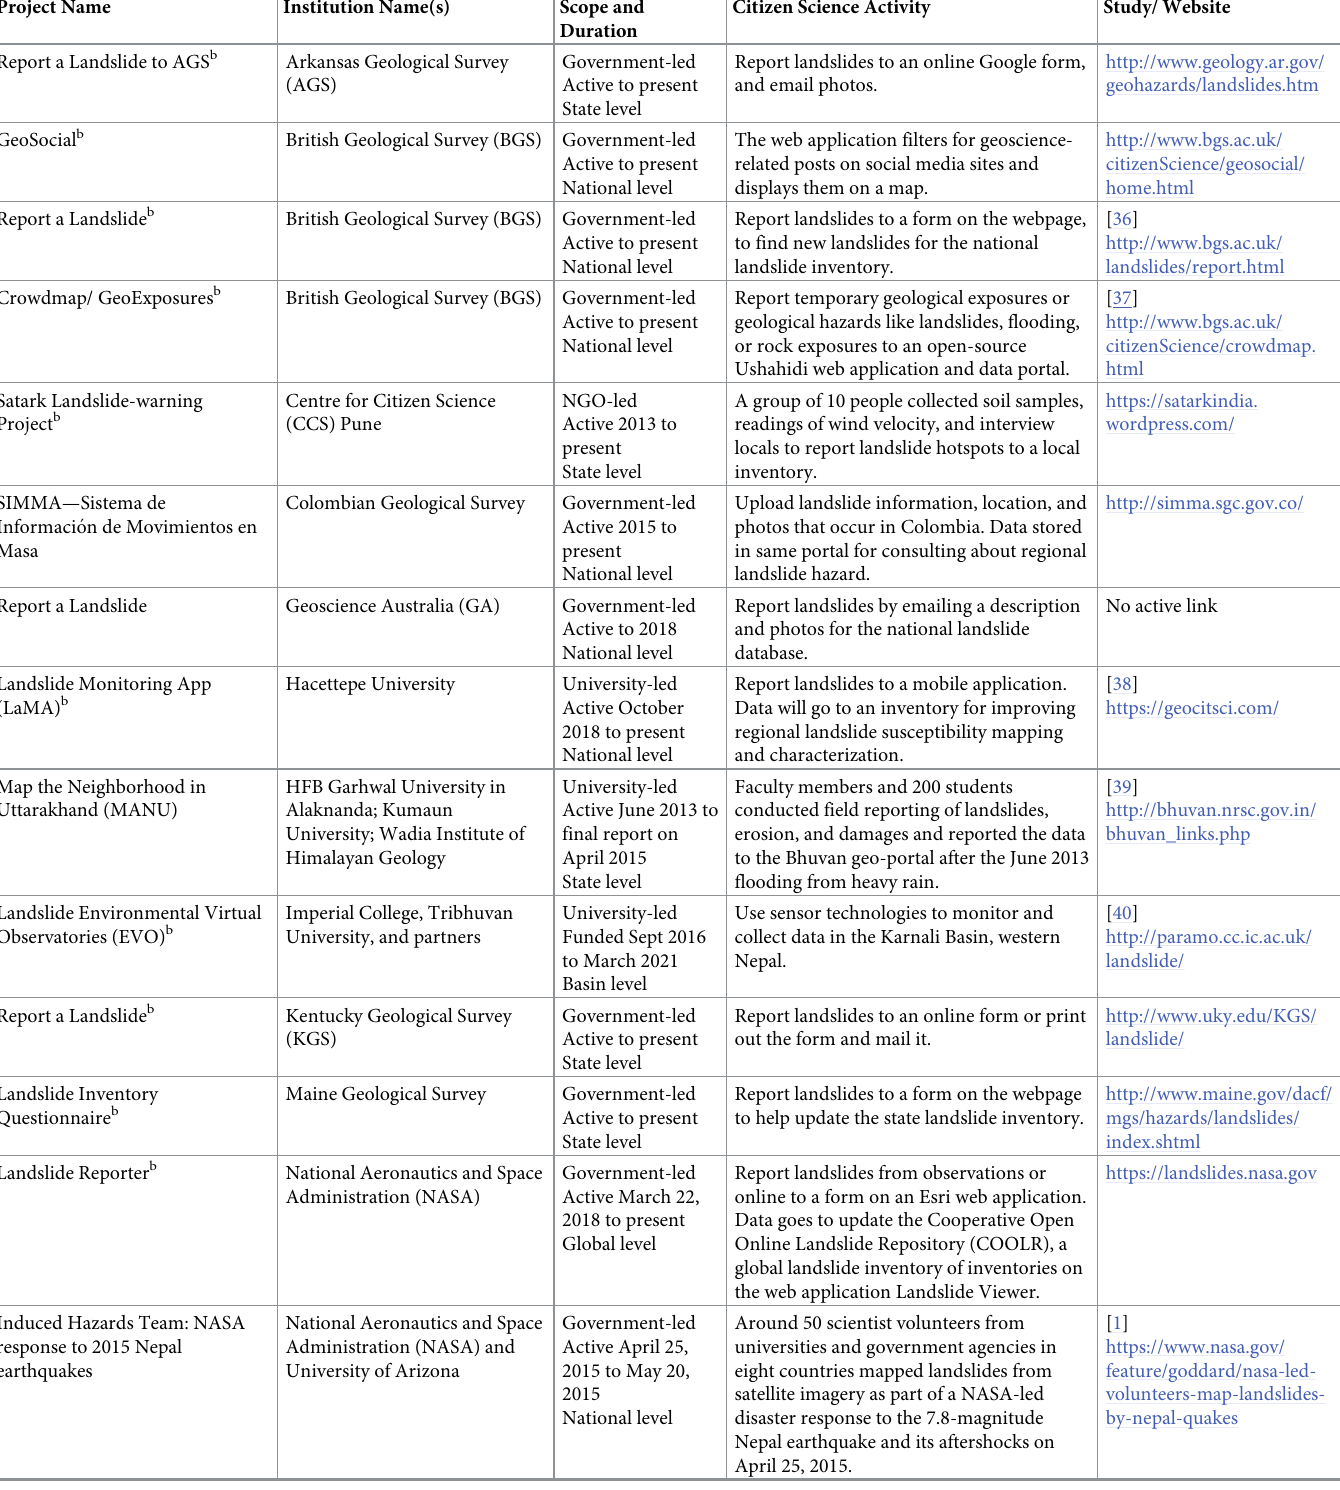
Table 1. List of all known a landslide citizen science